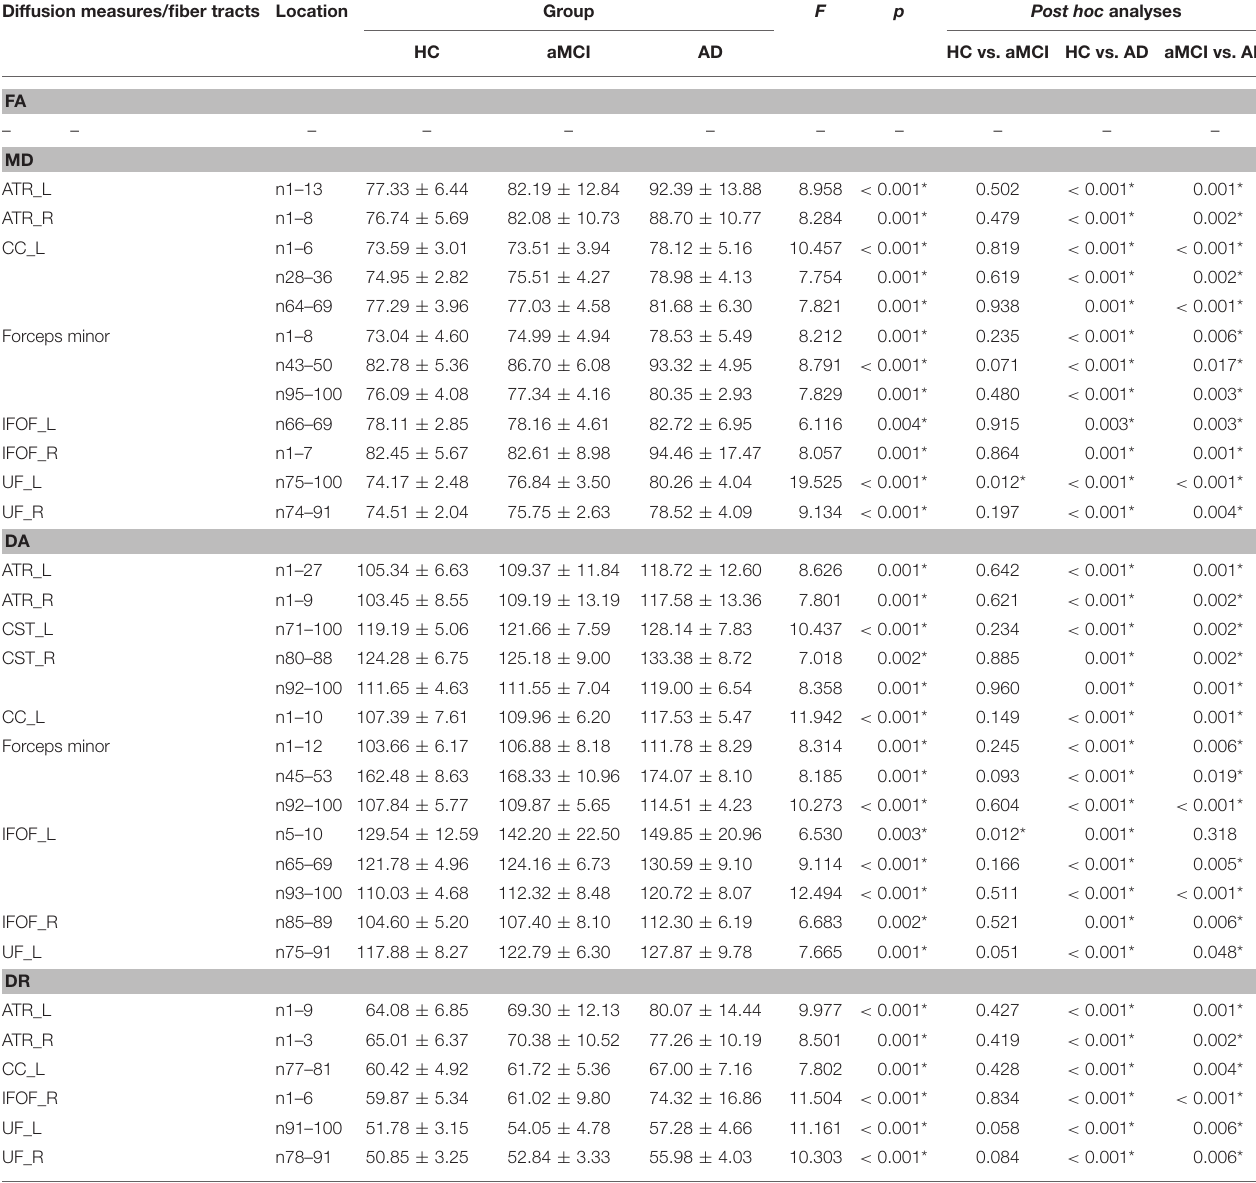
TABLE 3 | The location of tracts showing significant group differences in diffusion measures ( × 100) between HC, aMCI, and AD. Diffusion measures/fiber tracts Location Group F p Post hoc analyses HC aMCI AD HC vs. aMCI HC vs. AD aMCI vs.